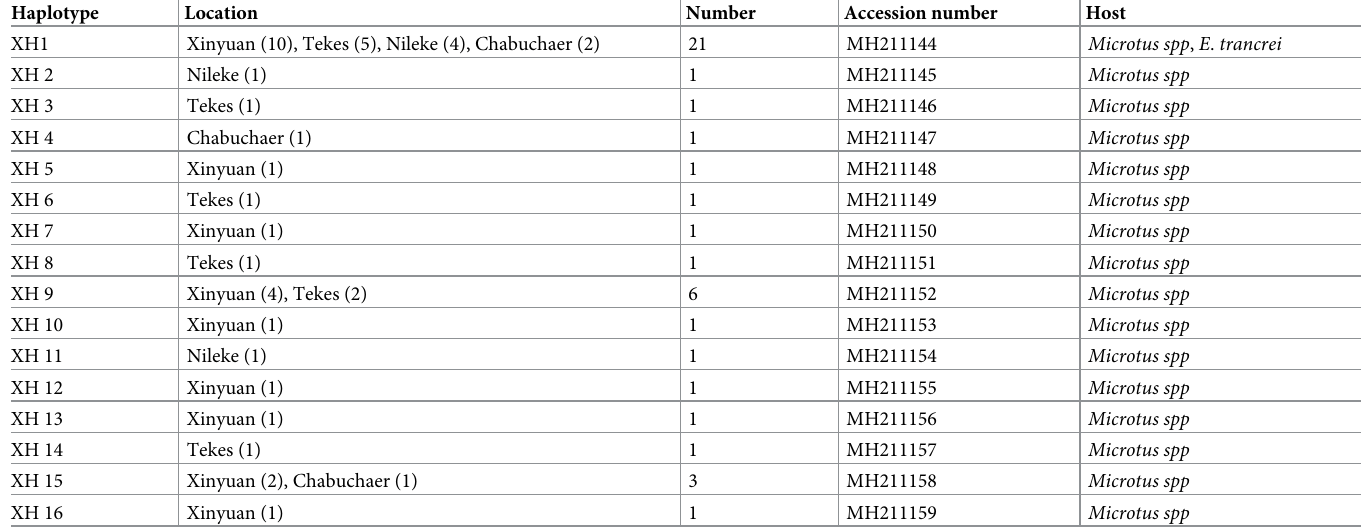
Table 6. E . multilocularis haplotypes characterized by partial cox1 sequences used for phylogenetic analysis. All samples were from small mammal hosts collected dur- ing the current study.